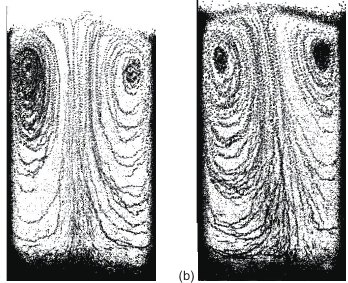
Figure 3. The granular convection flow obtained at f = 30 Hz and a = 70 m / s 2 (a) Case of up-down cycles. (b) Case of down- up